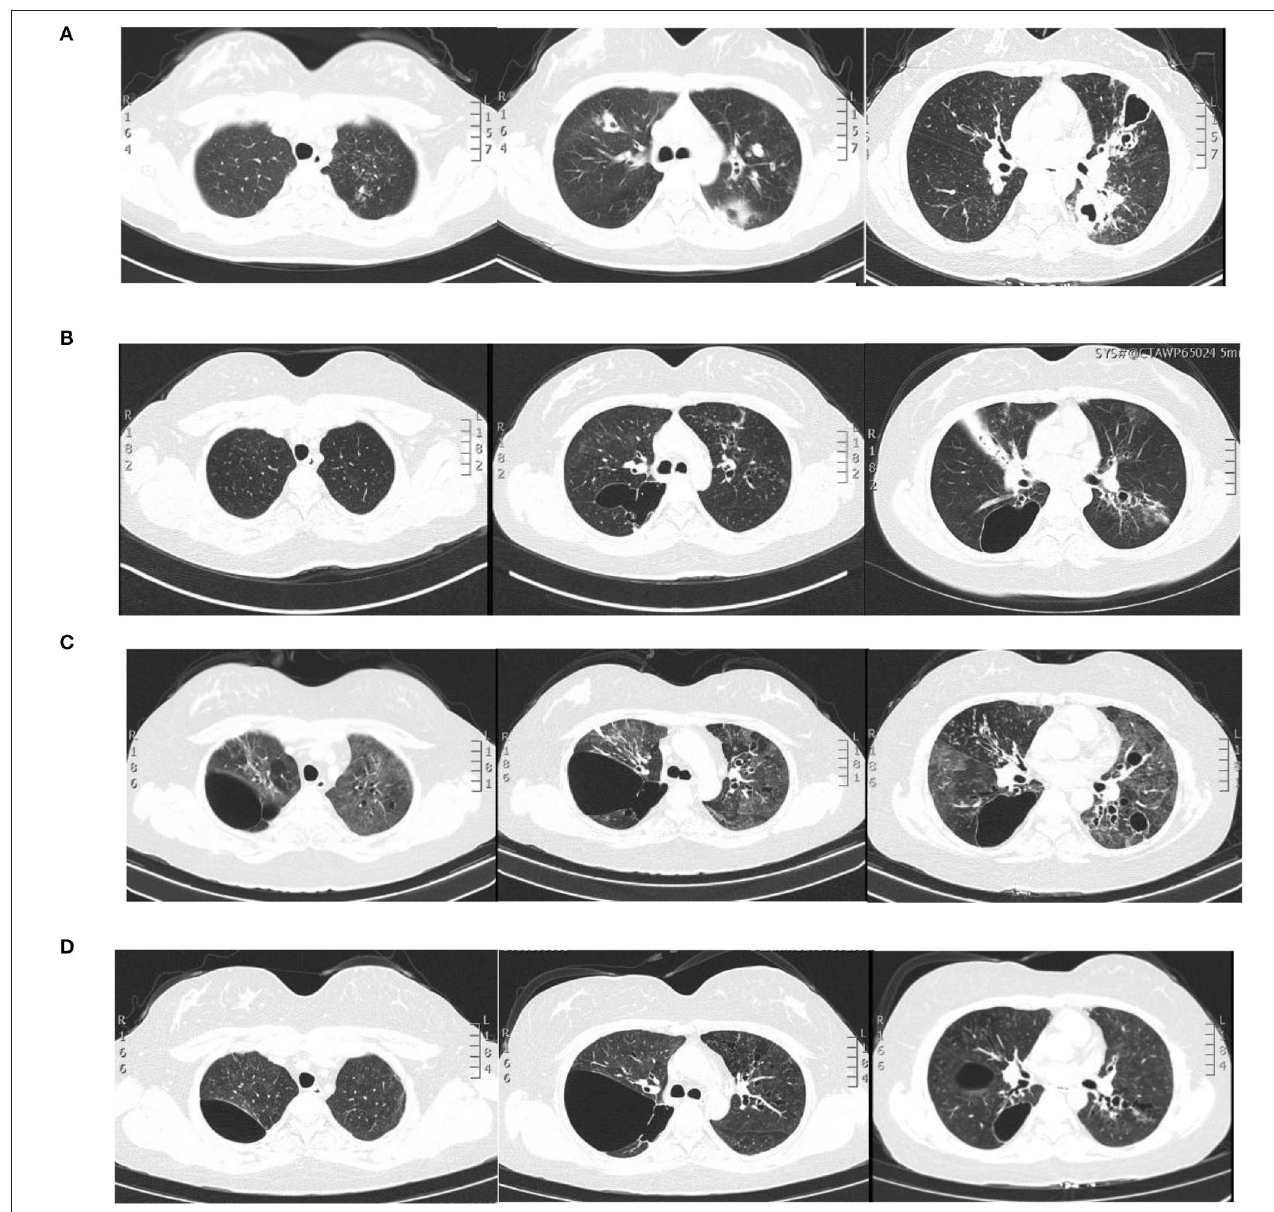
FIGURE 1 | Pulmonary imaging by CT scan. (A) December 2015: multiple cavitary lesions and multiple patchy shadows in both the upper lungs and the dorsal segment of the left lower lung, with bronchiectases in the right middle lung and the lingual and dorsal segments of the left upper and left lower lung. (B) December 2020: multiple cystic and columnar dilated bronchial shadows of variable size in both lungs, with exudative foci in the middle lobe of the right lung. (C) 8 May 2021: diffuse multiple ground glass shadows and scattered striae in both lungs and more cystic lesions than previously observed. (D) 18 August 2021: improved infiltrations and multilobed segmental bronchiectases and bullae in both